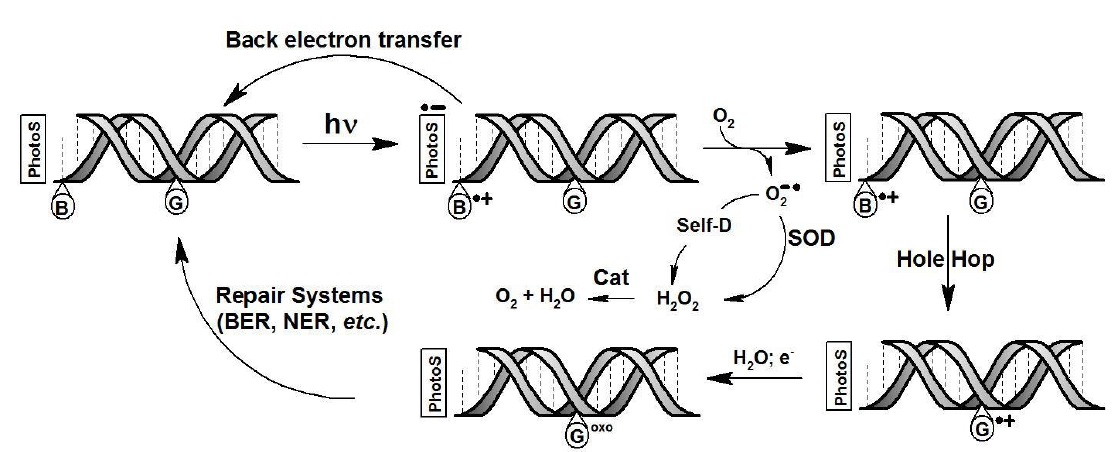
Figure 1: Graphical representation of long-distance oxidation of ds -DNA process. (PhotoS – photosensitizer, e.g.: anthraquinone, B-nucleobase, G-guanine, SOD-superoxide dismutase, Cat-catalase, Self-D – self-dismutation process).